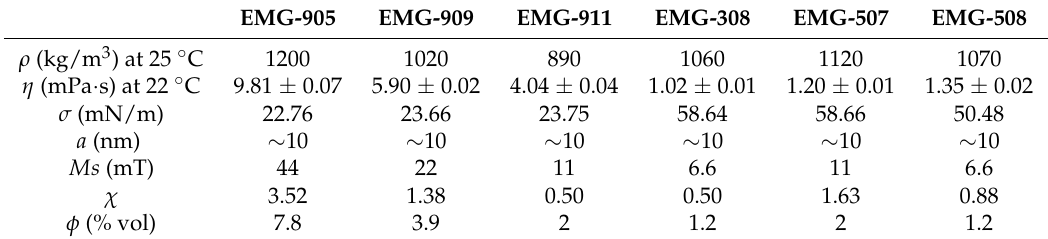
Table 1. Main properties of the ferrofluids considered in this study.